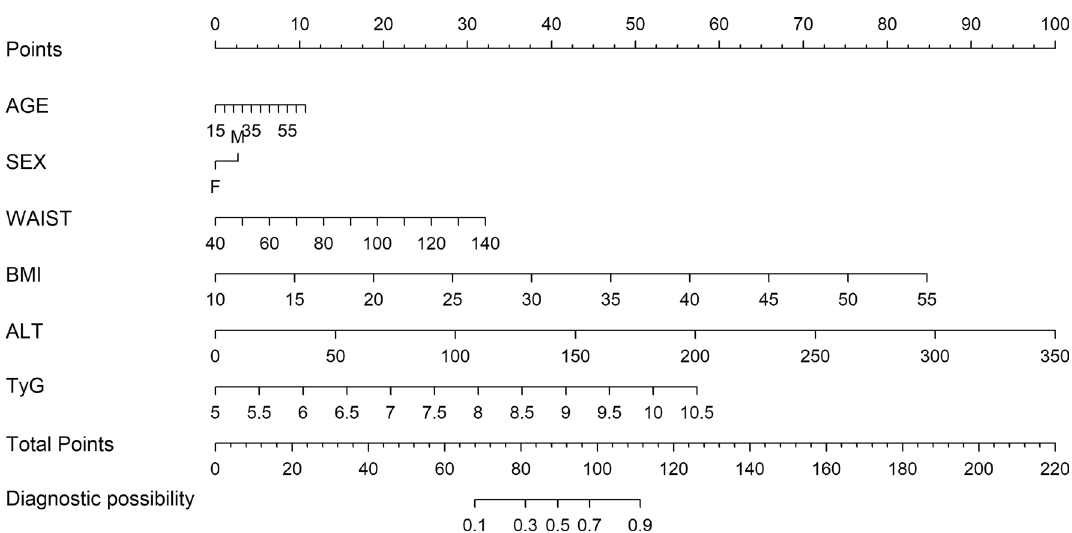
Figure 3. Nomogram to predict the risk of NAFLD. BMI, body mass index; ALT, alanine aminotransferase; TyG, triglycerides and glucose index; NAFLD, nonalcoholic fatty liver